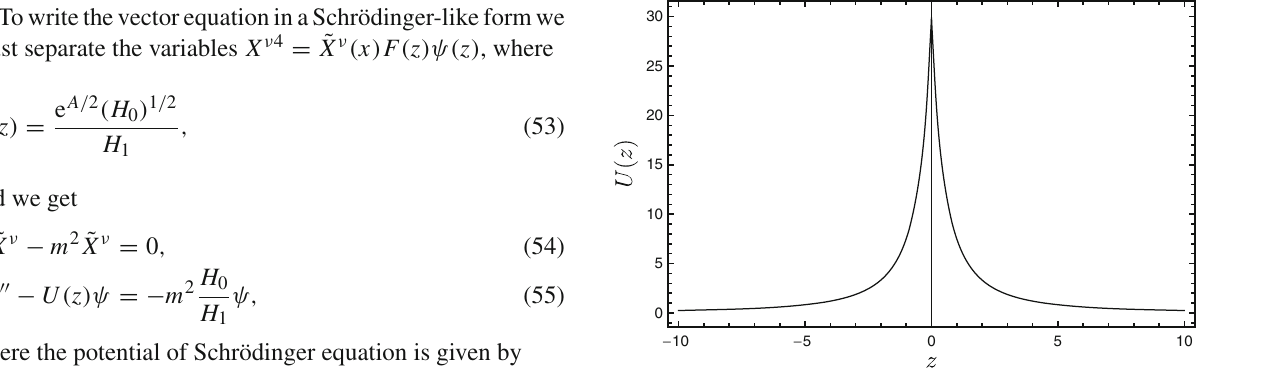
Fig. 1 Plot of regular part of Schrödinger potential for KR field in Randall–Sundrum delta like scenario with k = 1 and α + β =